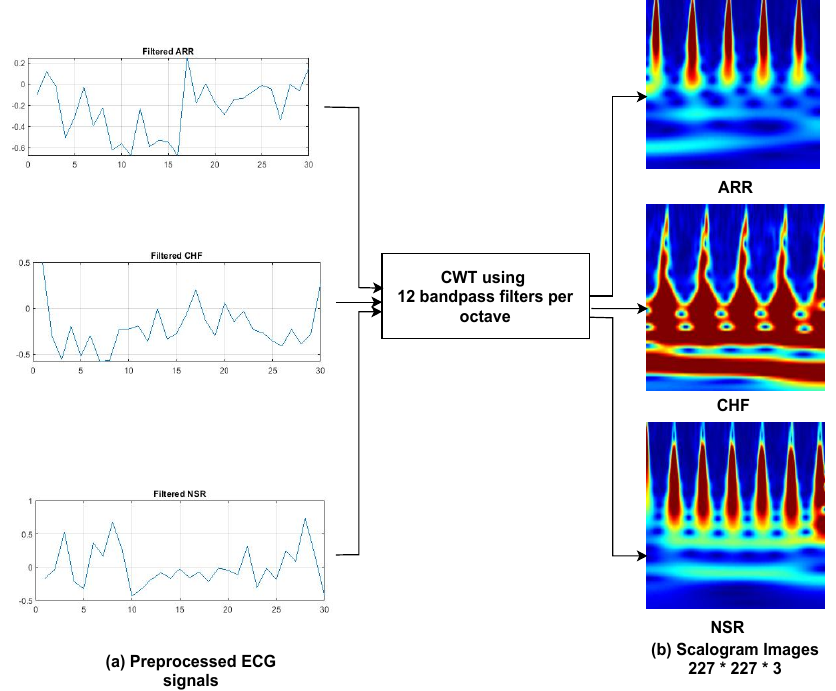
Figure 5. Conversions of 1D ECG signals into Scalogram images using